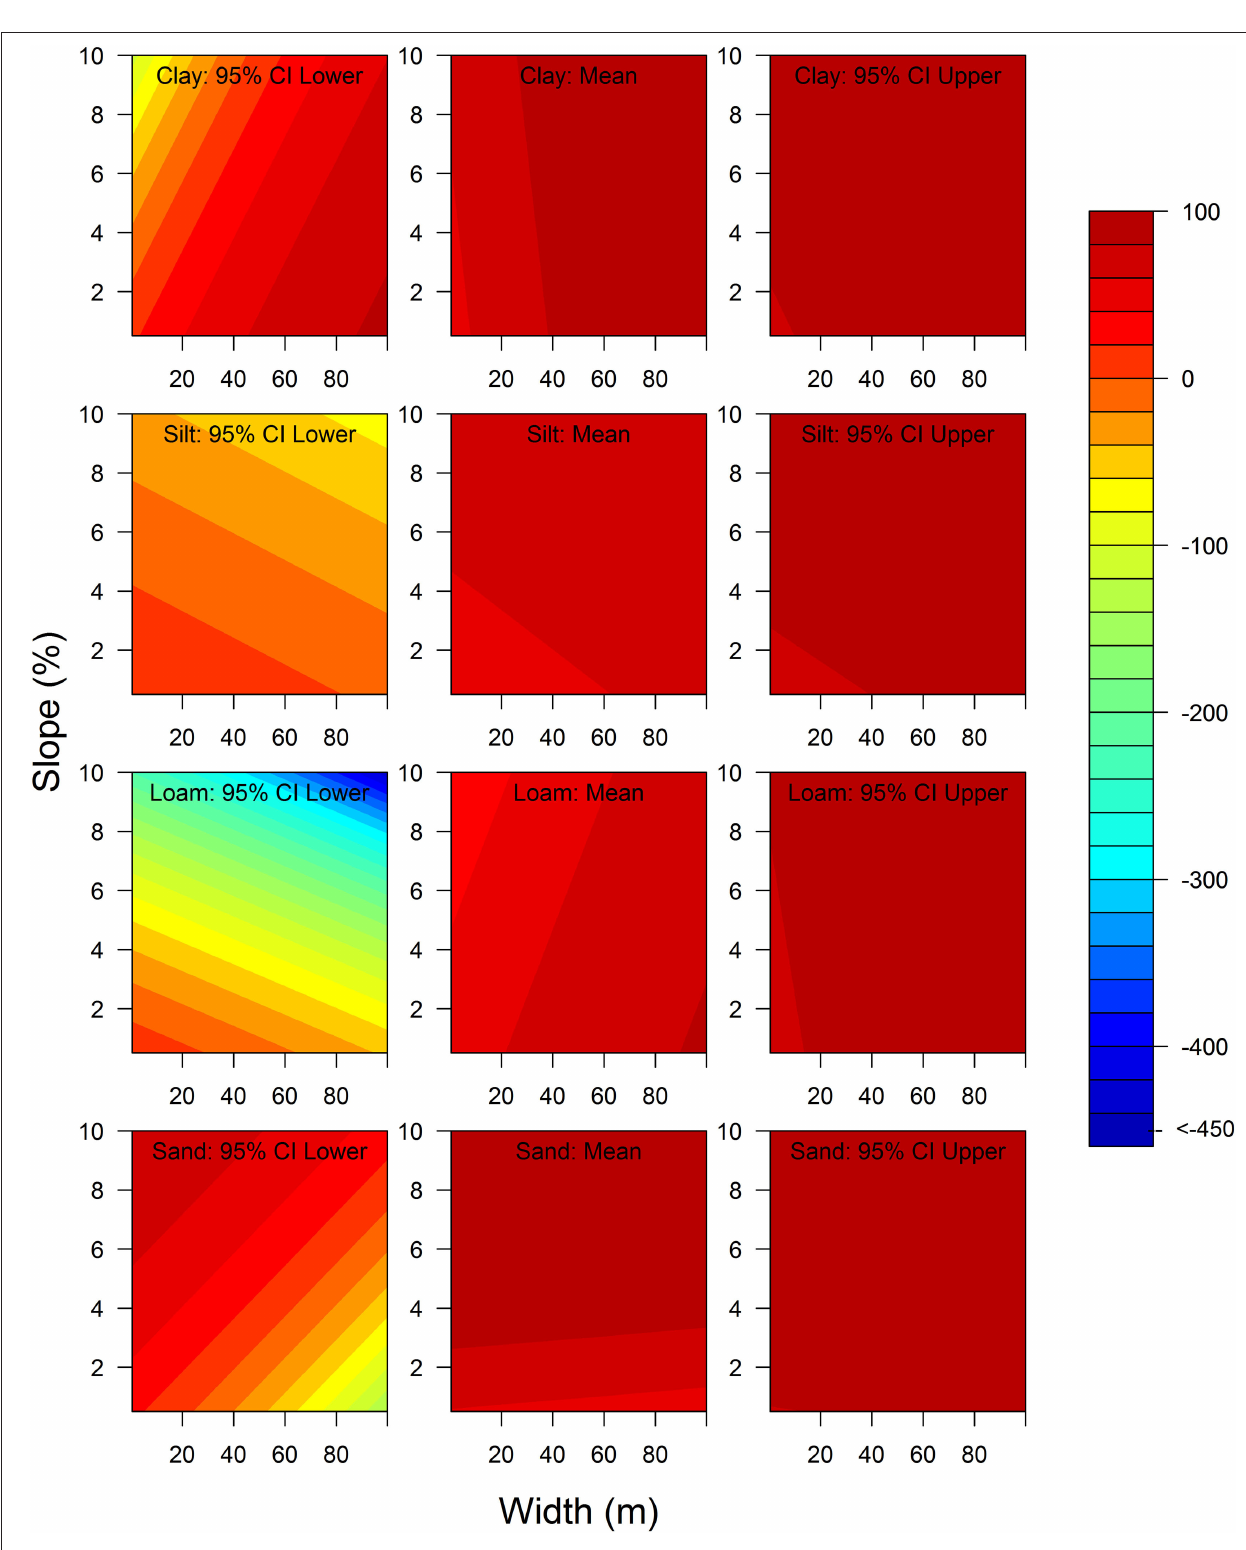
Frontiers in Water |